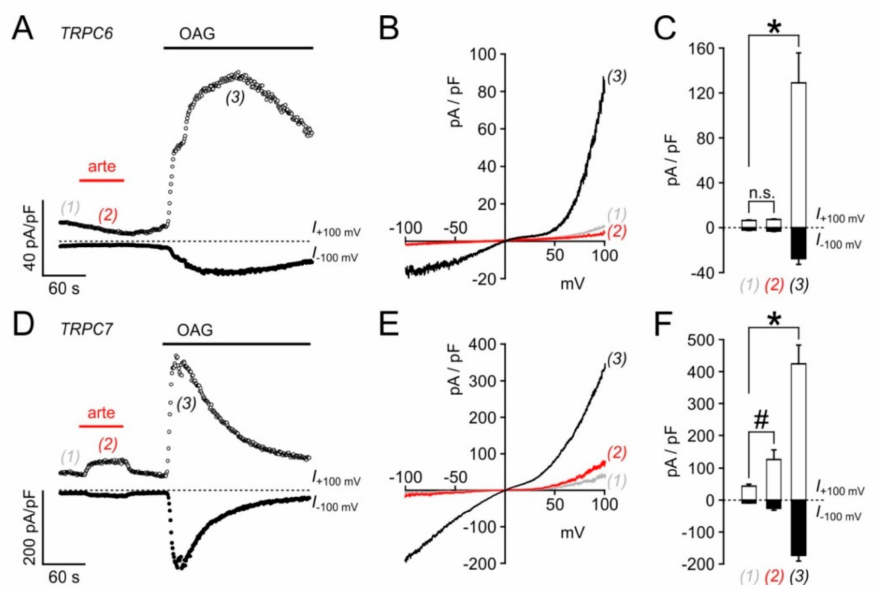
Figure 6. E ff ects of artemisinin on ionic currents through TRPC6 and TRPC7. Whole-cell current densities were measured in HEK TRPC6-YFP ( A – C ) and in HEK TRPC7-YFP cells ( D – F ) in a similar fashion as shown in Figure 4A, during application and wash-out of 100 µ M artemisinin (arte). To ascertain that the cells expressed the respective channel, cells were subsequently exposed to 50 µ M OAG as indicated by the black bars ( A , D ). ( B , E ) Current densities during voltage ramps (ranging from − 100 to + 100 mV at 400 mV s − 1 ) taken at the indicated time points from experiments shown in ( A , D ). ( C , F ) Current densities before (1), and during (2) exposure to 100 µ M artemisinin, and peak current densities reached during stimulation with 50 µ M OAG (3) were recorded in 9 cells, each, and depicted as means and S.E. Statistically significant di ff erences were denoted as * and # for the indicated comparisons ( p < 0.05; Student´s t -test with paired data); n.s.: statistically not